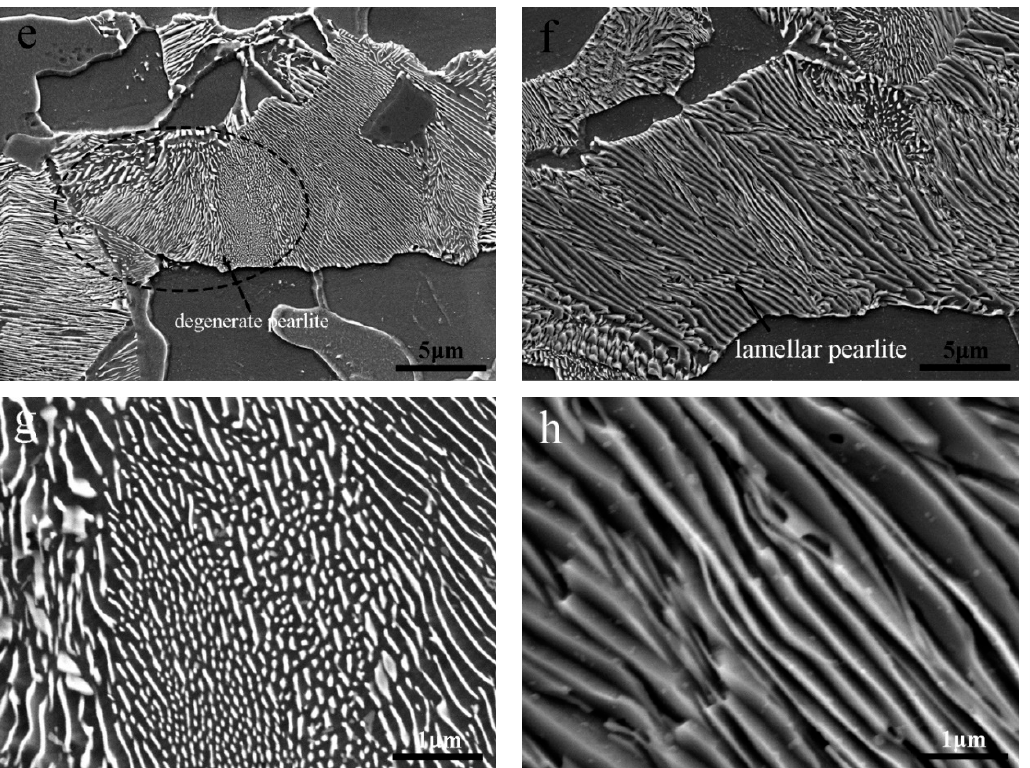
Figure 5. The microstructures of the U-section steel seen by an optical microscope ( a , b ) and scanning electron microscope ( c – h ). ( a , c , e , g ) Steel 1; ( b , d , f , h ) Steel 2.